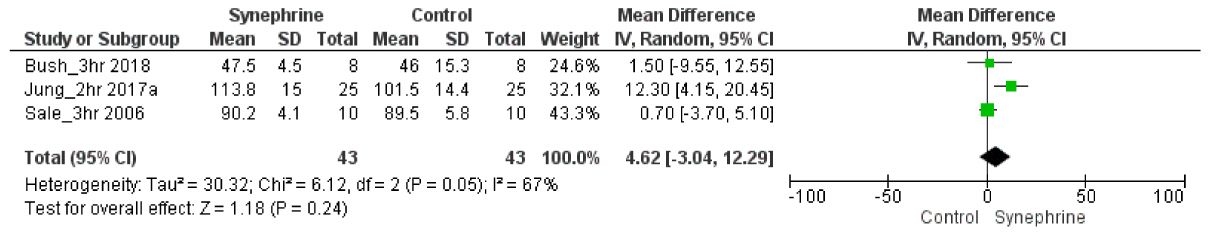
Figure 7. Forest plot diagram of synephrine acutely on blood glucose in intervention and control